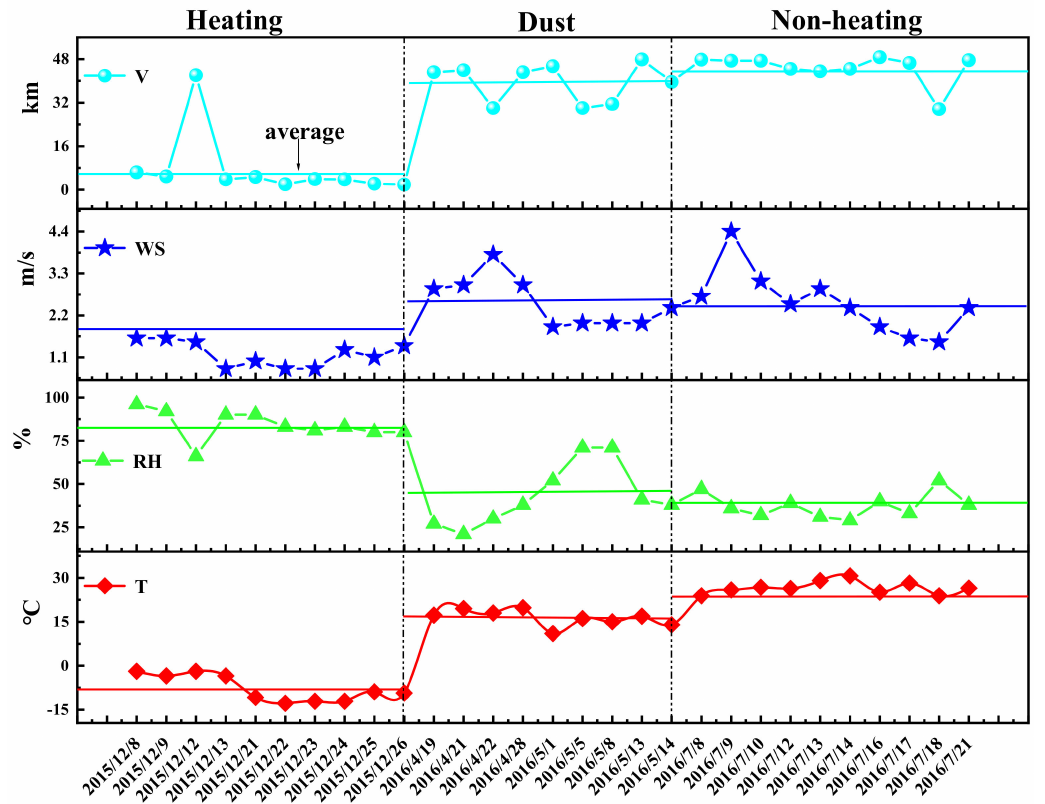
Figure 4. Seasonal variation in meteorological parameters in Dushanzi